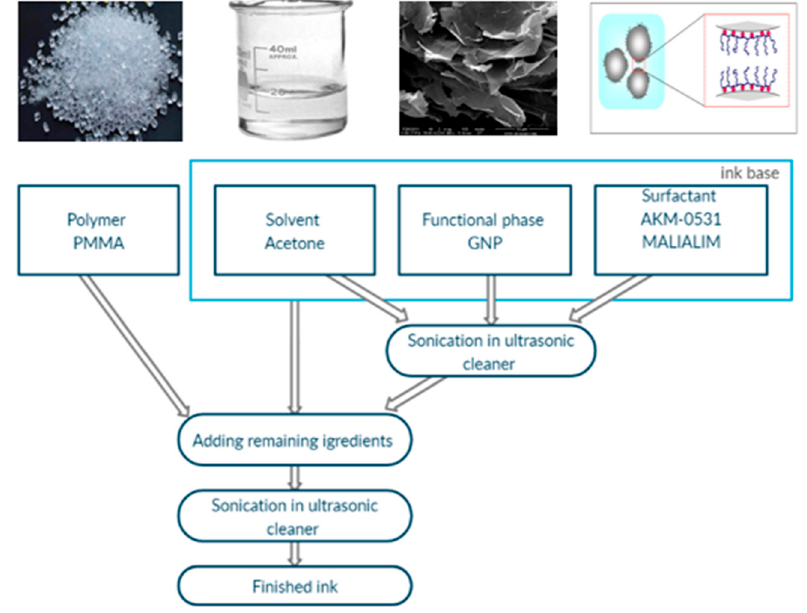
Figure 8. The technology of the graphene inks with graphene nanoflake production